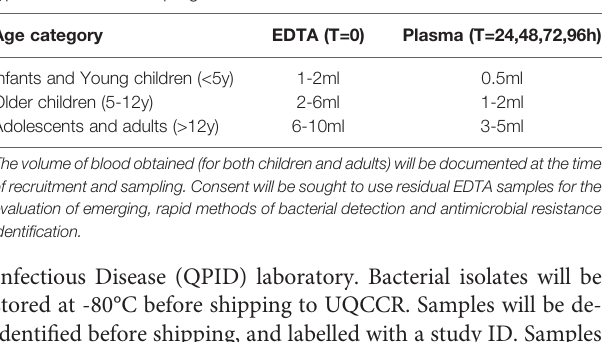
TABLE 2 | Appropriate study sample volumes according to age, and sample type. ‘ T ’ is time of sampling in hours since recruitment.